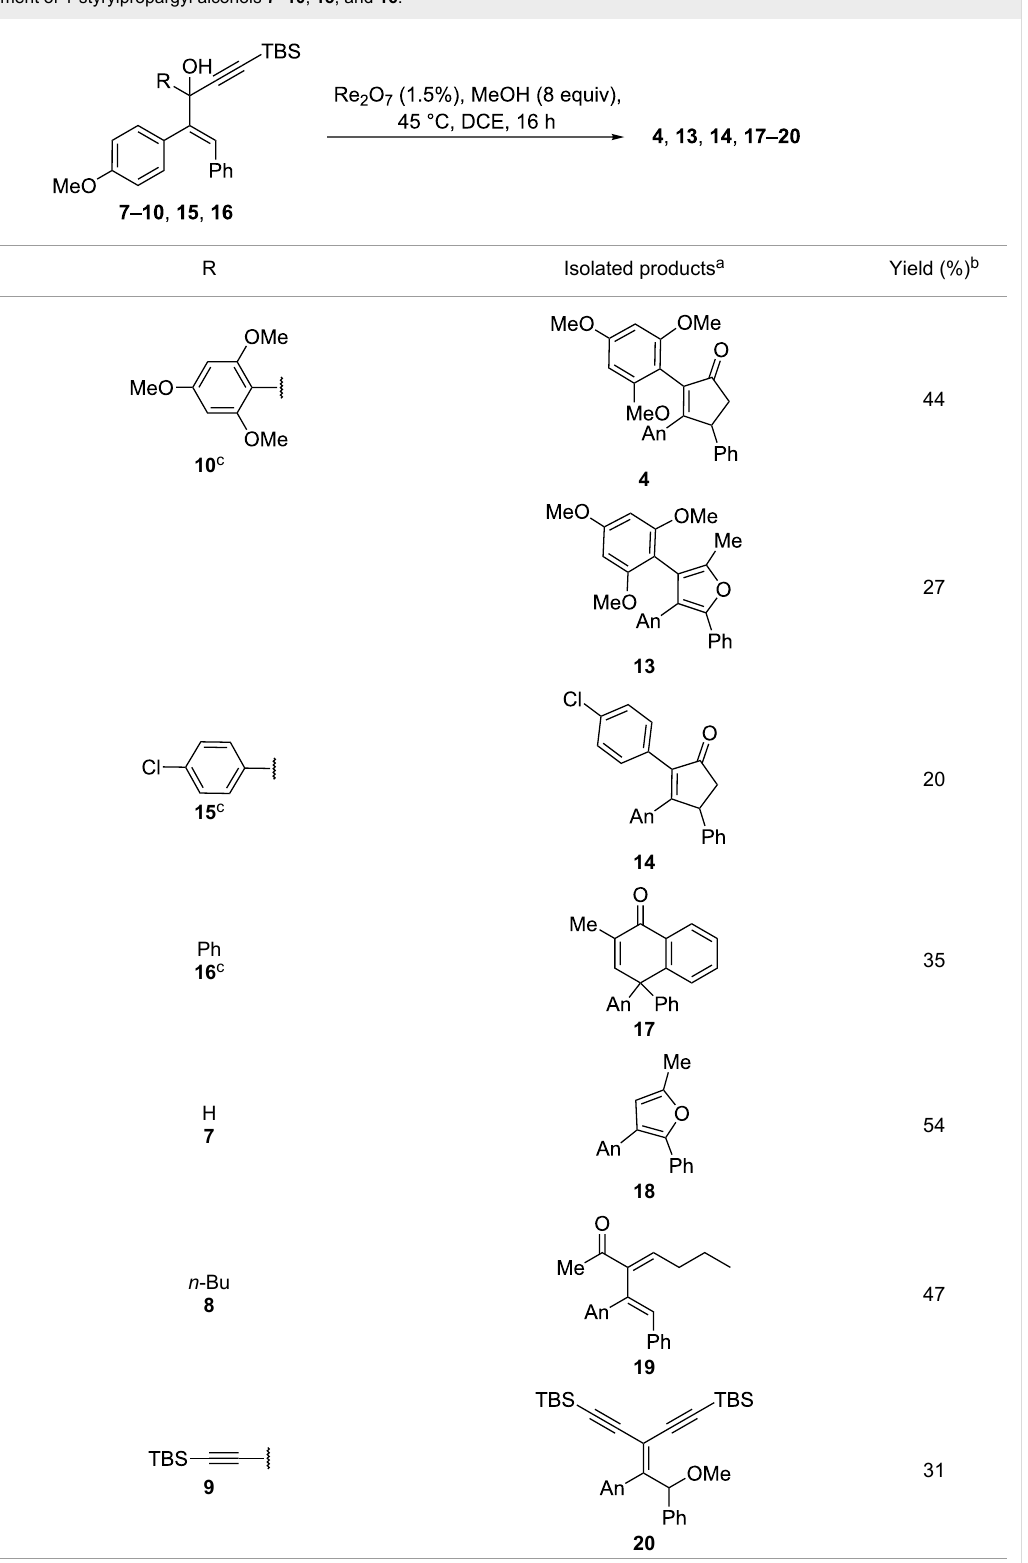
Table 1: Rearrangement of 1-styrylpropargyl alcohols 7 – 10 , 15 , and 16